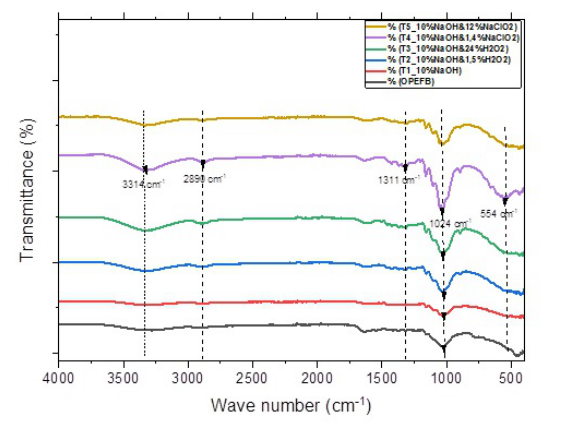
Fig. 5. FTIR Spectrum Results of OPEFB after pretreatment